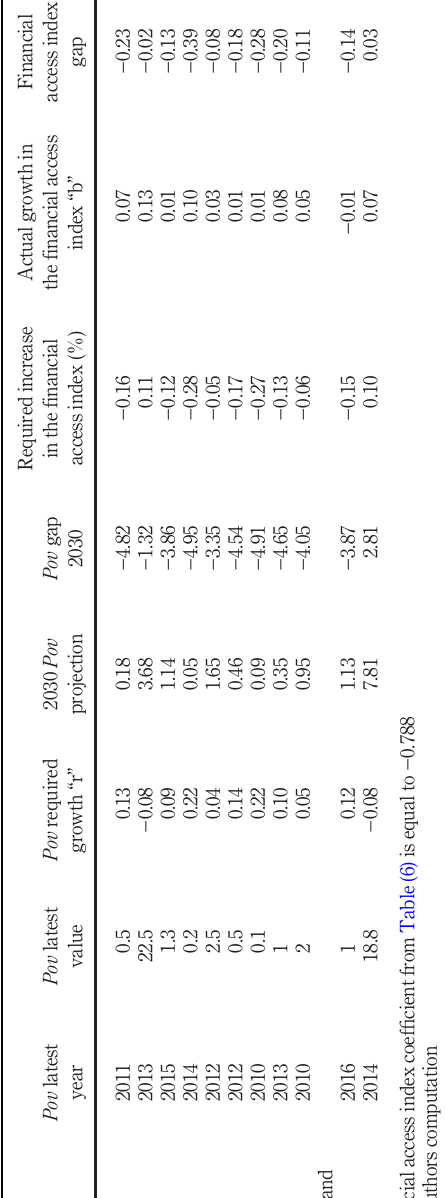
Table A10. Extreme poverty and financial access gap analysis in EMs – assessment against the 5% poverty